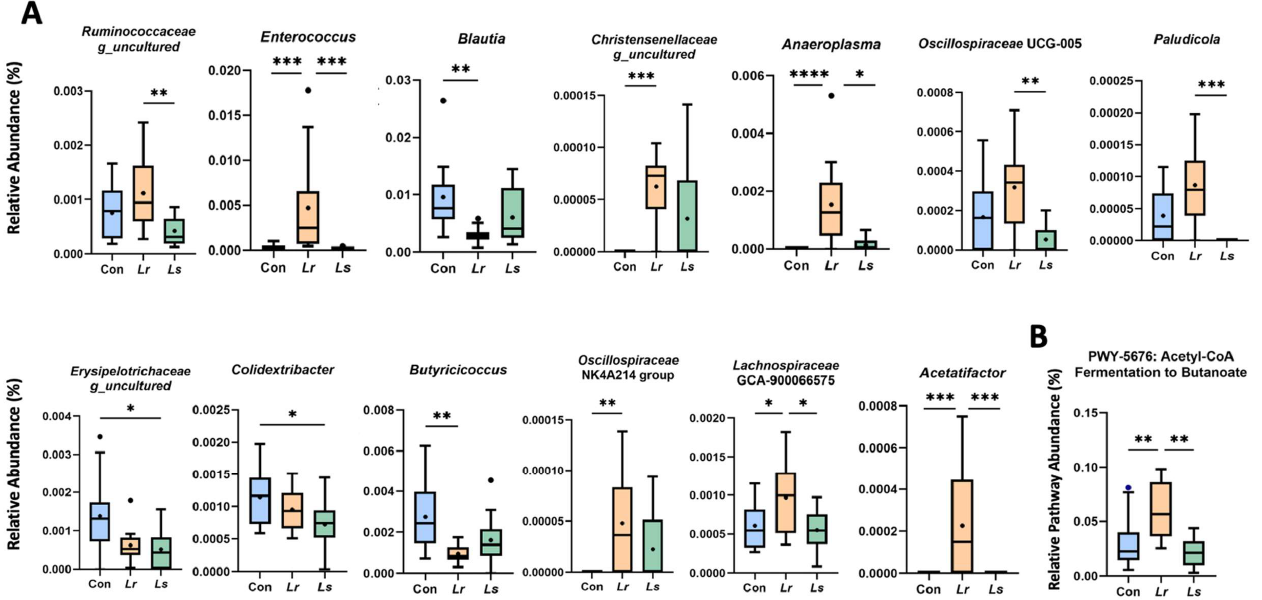
Figure 3. Differentially abundant taxa and functional predictions following probiotic treatment . ( A ) Box plots of significantly different genera between groups. Genera are listed in order of decreasing feature importance (right to left), as determined by a trained classification model. ( B ) Metagenomic analysis of butanoate metabolism evaluated by PICRUSt2. N = 10–14 mice/group. Con—Control; Lr — L. rhamnosus HA-114; Ls — L. salivarius HA-118. Means are indicated by the black circles located within the box. The box extends from the 25th to 75th percentiles with the whiskers representing the furthest point that is within 1.5 times the IQR.* p < 0.05; ** p < 0.01, *** p < 0.001, **** p < 0.0001.